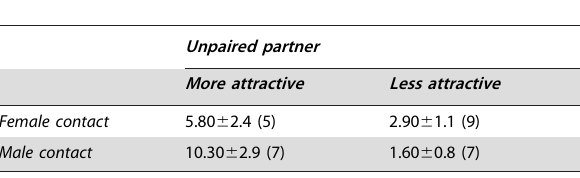
Table 2. Mean ( 6 SE) female and male contact initiations/h towards an unpaired conspecific. The number of tested pairs is given in